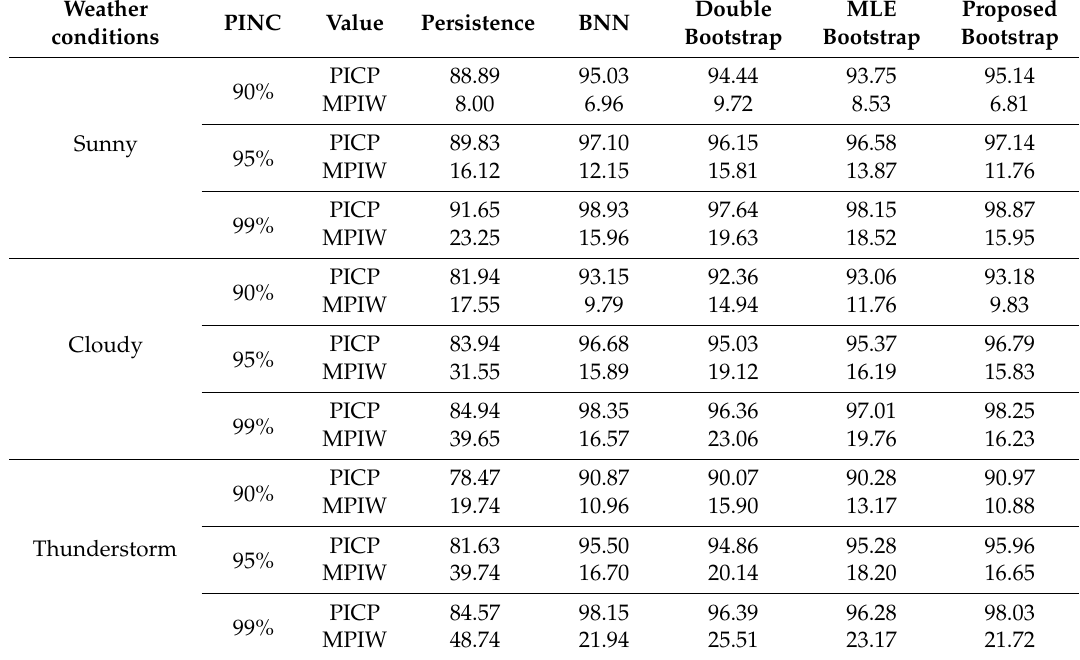
Table 2. Performance comparison of various constructed prediction intervals (PIs) under different weather conditions.